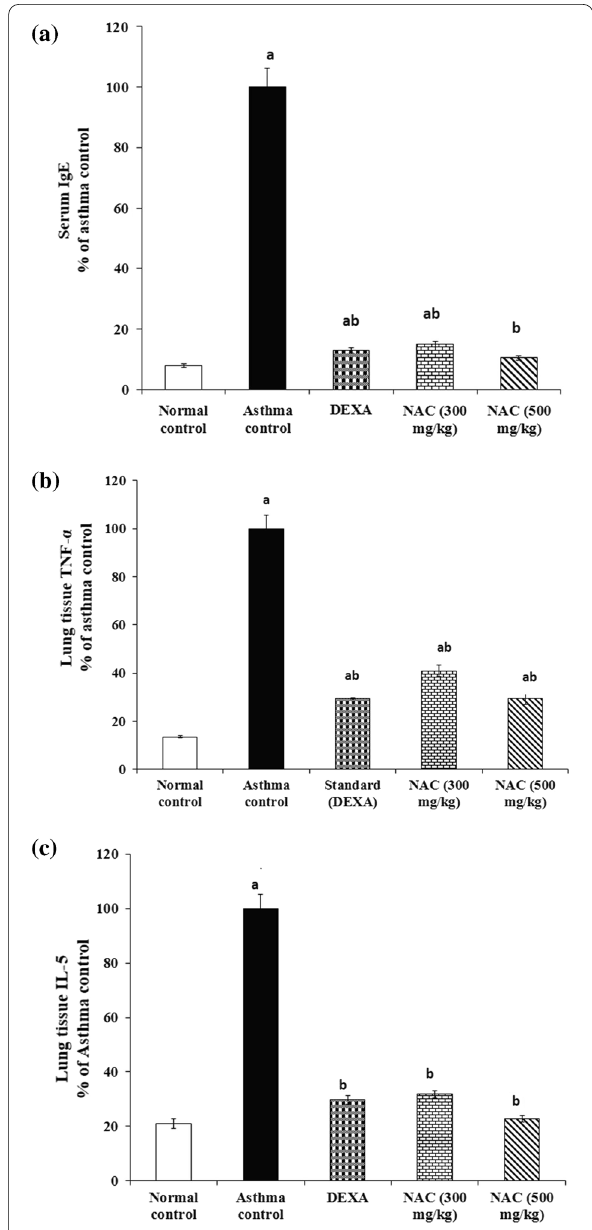
Fig. 2 NAC effects on the levels of a serum IgE, b lung TNF‑α and c lung IL‑5 in asthmatic Rats. The results were presented as % of asthma control ( N 8 rats). One‑way analysis of variance (ANOVA) was used = in the statistical analysis, followed by the Bonferroni test. a at p < 0.05, considered significantly different from normal control. b at p < 0.05, considered significantly different from the asthma control group. c at p < 0.05, considered significantly different from the DEXA